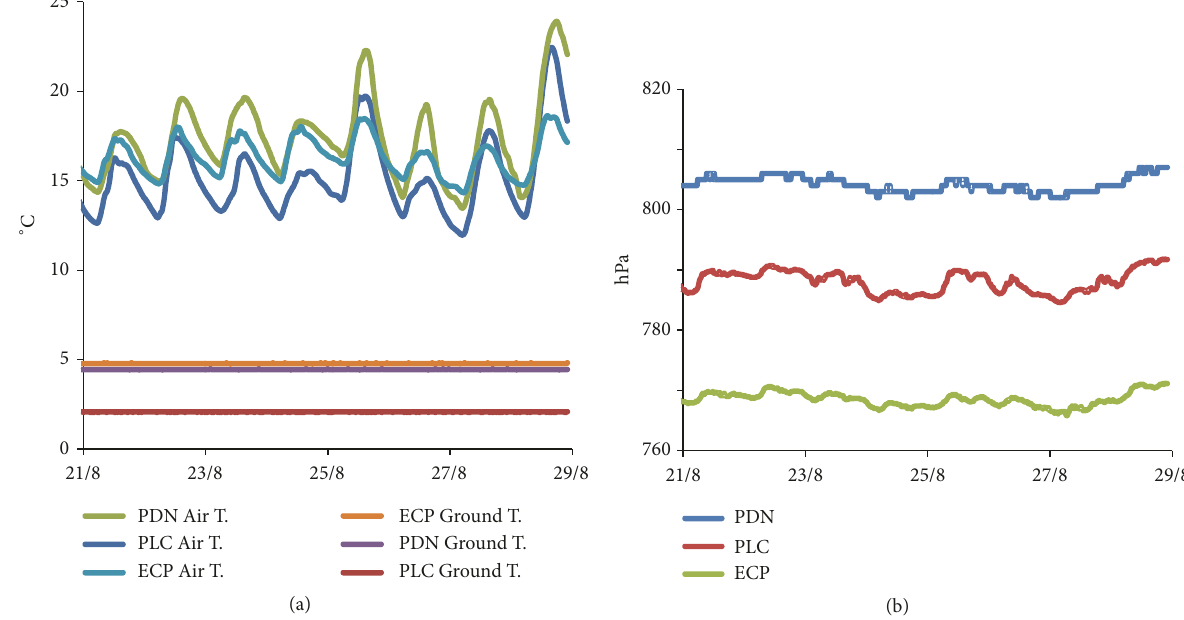
Figure 4: Temperatures (a) and air pressure (b) at the three stations in the 21-29 August period.